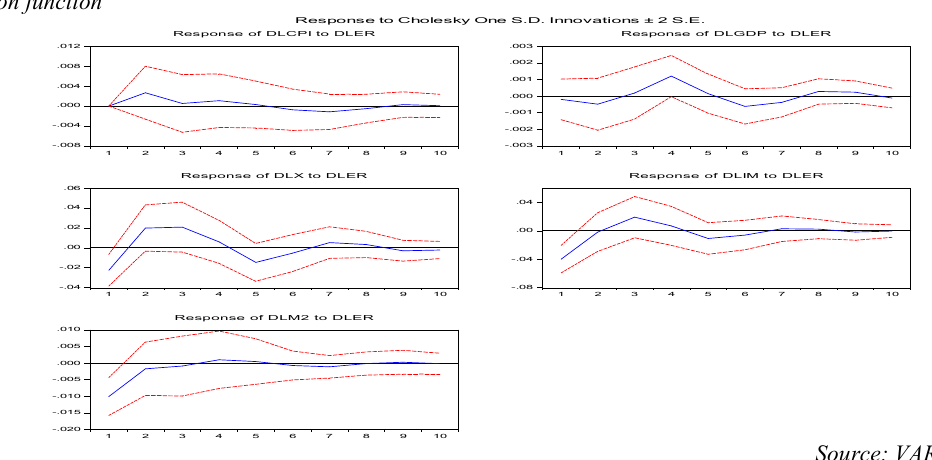
Fig. 2. Impact of exchange rate shock on other endogenous variables